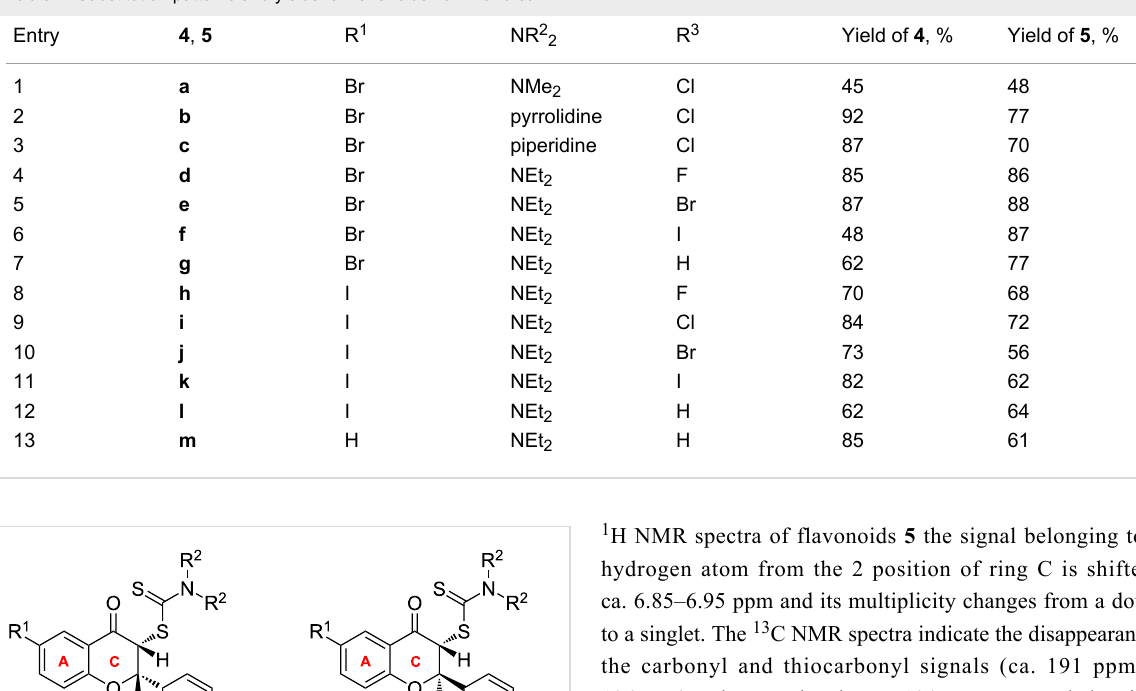
Table 2: Substitution patterns and yields for flavonoids 4a – m and 5a – m .